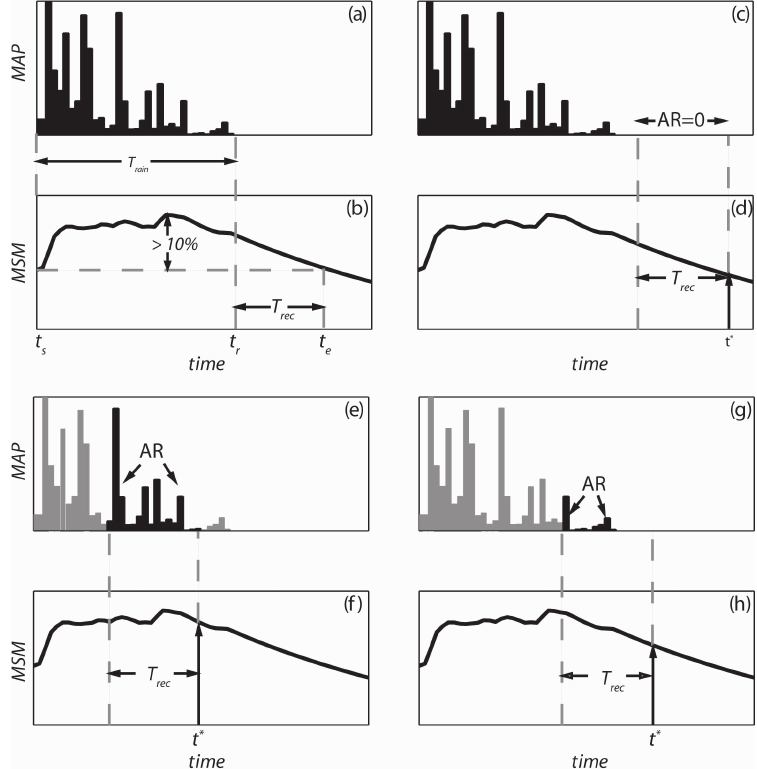
Fig. 4. Schematic of the approach used to estimate the recession time T rec . (a)–(b) Time series of MAP and mean soil moisture (MSM) in the top 10cm. Rainfall starts at time t s and ends at time t er , with duration T rain = (t er − t s ) . MSM decreases after t er and, at time t e , it reaches the initial value at t s . The recession time is T rec = (t e − t er ) . T rec was estimated considering rainfall events causing an increase of MSM larger than 10% of its initial value. (c)–(h) Computation of AR in three cases: the forecast event starts well after a storm (c, d); the forecast event starts during a storm (e, f); and the forecast event starts few hours after a storm (g,